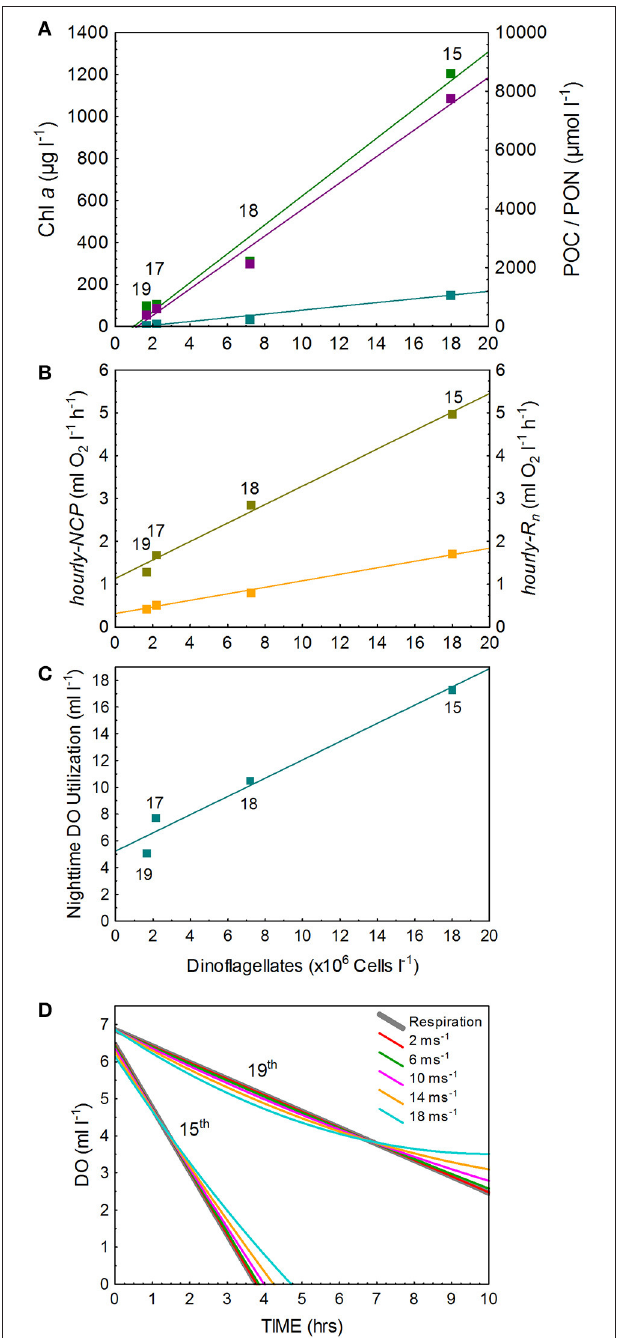
FIGURE 3 | The relationships between dinoflagellate concentration (DC) and (A) the bloom biomass parameters of Chl a , POC, and PON (Chl a = 68.7*DC—66.3 [ r 2 = 0.98]; POC = 449.9*DC—522.4 [ r 2 = 0.99]; PON = 63.7*DC—80.6 [ r 2 = 0.98]), (B) hourly-NCP and hourly-R n ( hourly-NCP = 0.219*DC + 1.13 [ r 2 = 0.99]; hourly-R n = 0.076*DC + 0.31 [ r 2 = 0.98]), and (C) nighttime utilization of O 2 (O 2 = 0.68*DC + 5.23 [ r 2 = 0.97]) and (D) nighttime depletion of O 2 under the high and low respiration rates measure on the 15 and 19 March 2013 after accounting for air-sea exchange at varying wind